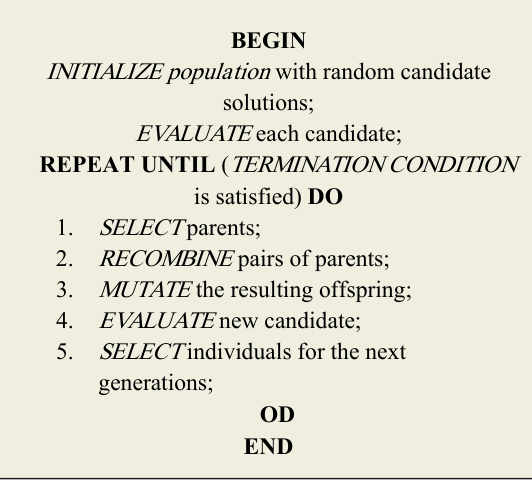
Fig. 1. Pseudo-code for typical